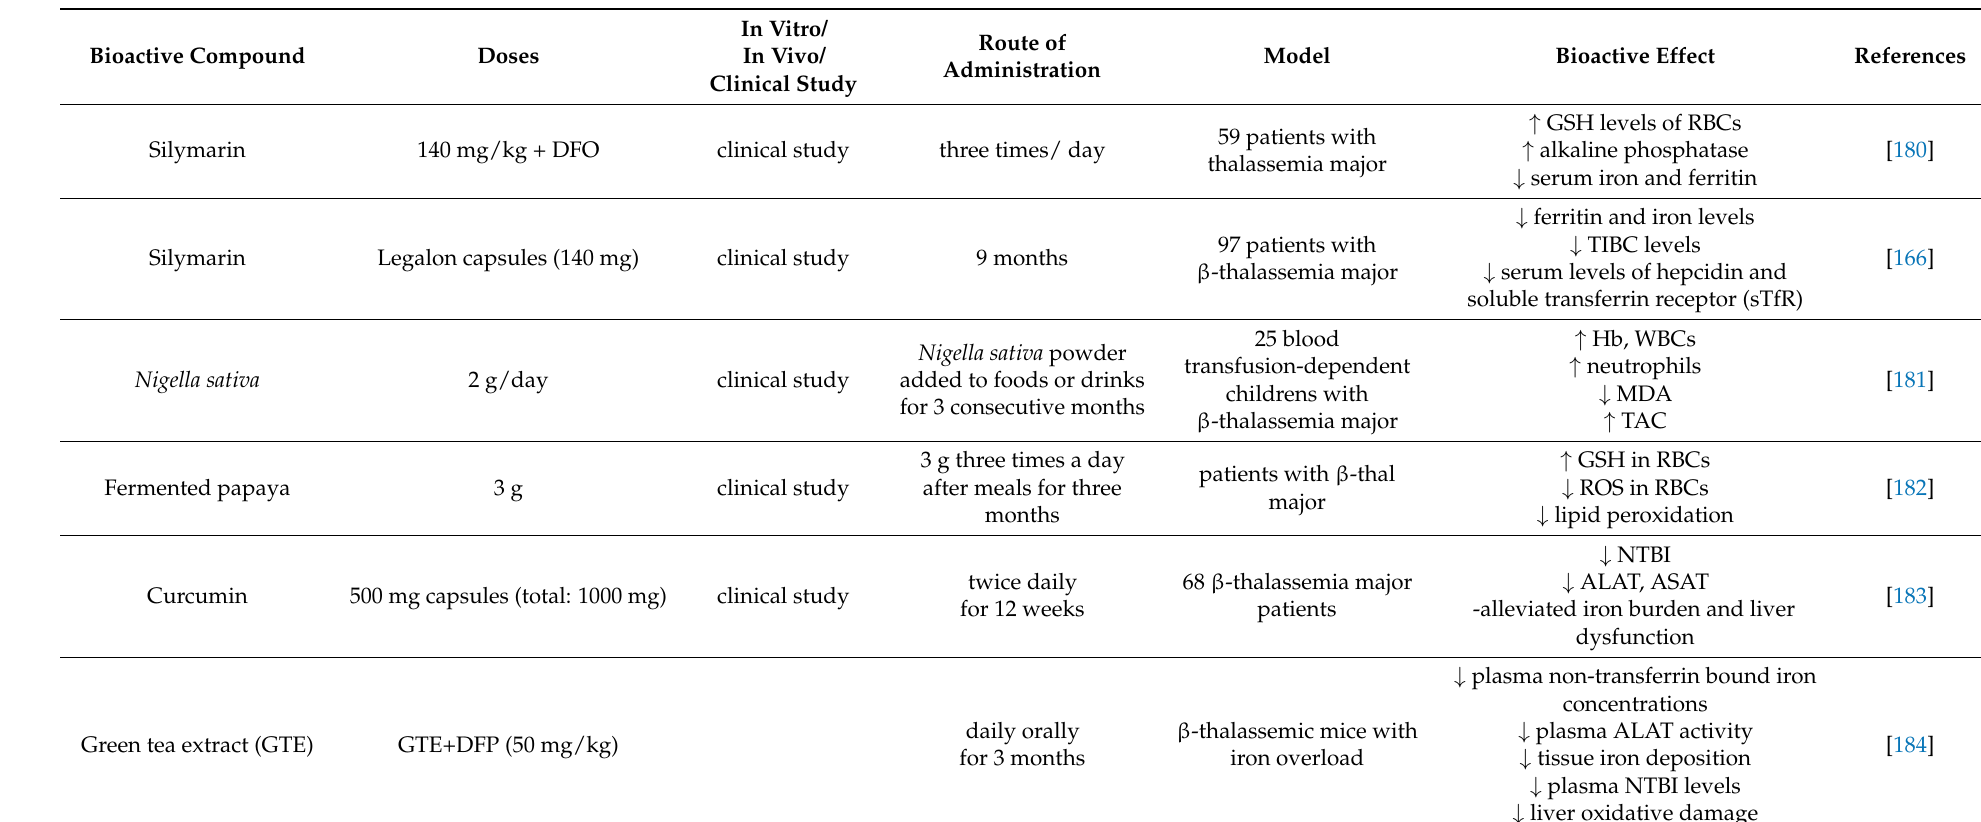
Table 5. Pharmacological effects of natural antioxidants in β -thalassemia major